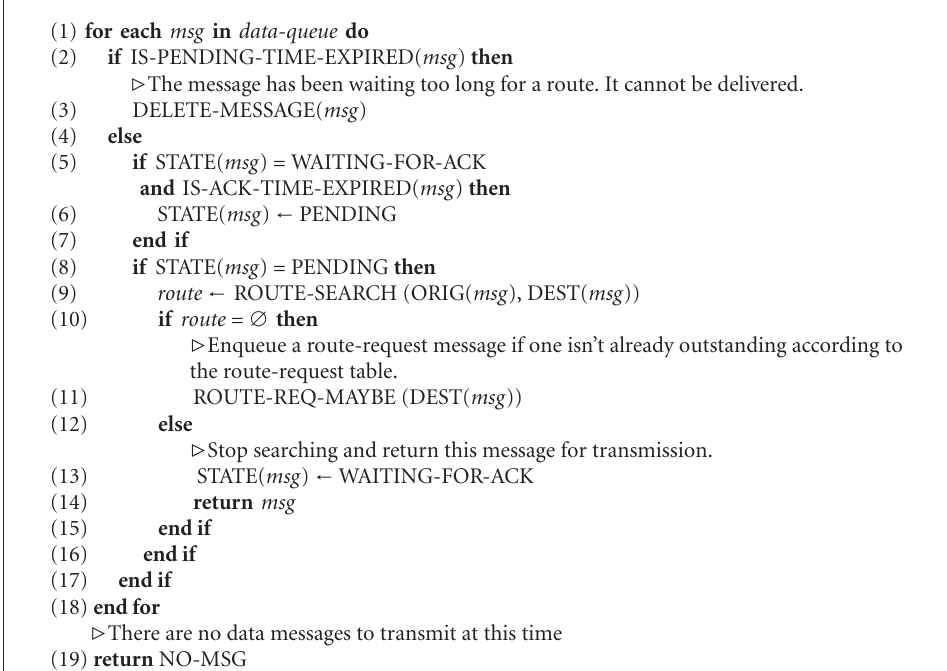
Algorithm 1: The algorithm for obtaining the next user-data message from the data queue.